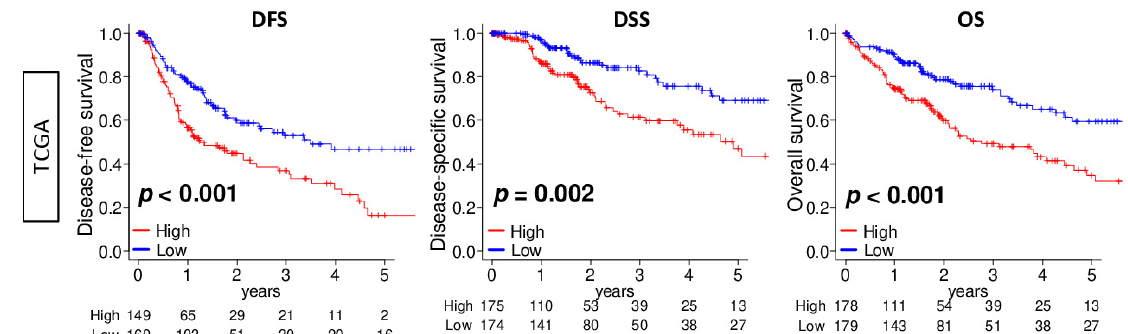
Figure 2. Association between the DNA repair score and HCC patient survival in the TCGA cohort. Kaplan–Meier survival curves comparing the low and high DNA repair score HCC for disease-free survival (DFS), disease-specific survival (DSS), and overall survival (OS) in the TCGA cohort ( n = 358). We divided the cohort into low and high DNA repair score groups using the median value as the cut-off. The p -value was calculated using a log rank test.